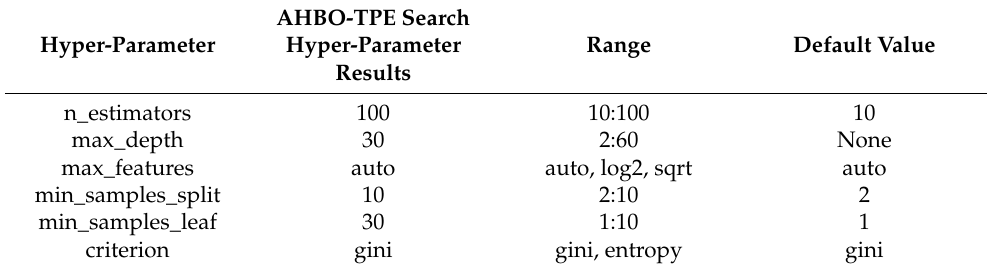
Table 10. RF Model AHBO-TPE Search Hyper-parameter Results (Ember Dataset).